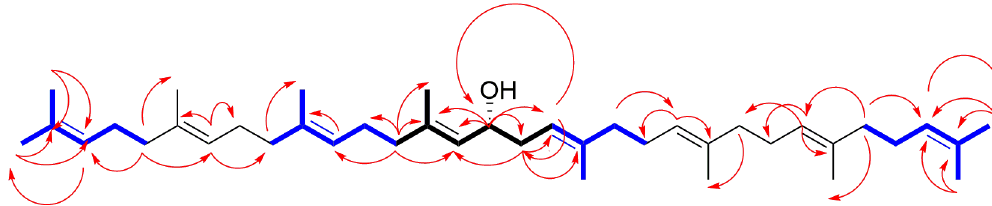
Figure 2. Key correlations in the COSY (black colored), TOCSY (blue colored) and HMBC (red arrows) spectra used for the characterization of Compound 1 .